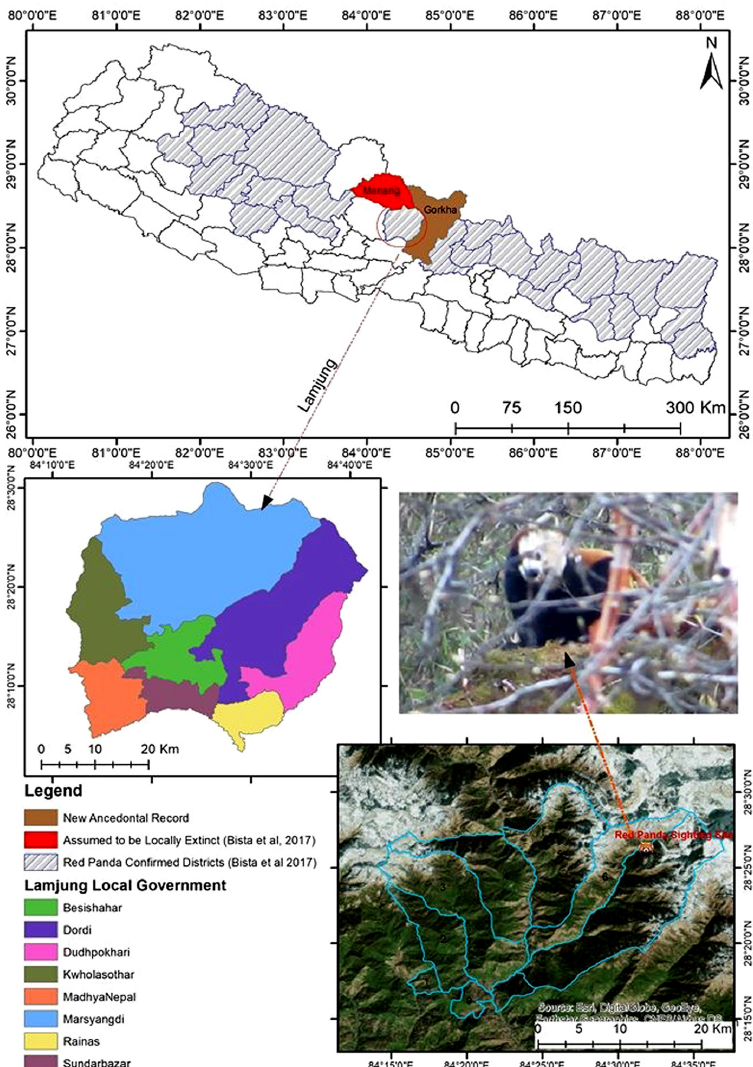
Figure 1. Study area in Marsyangdi Rural Municipality, Lamjung District,